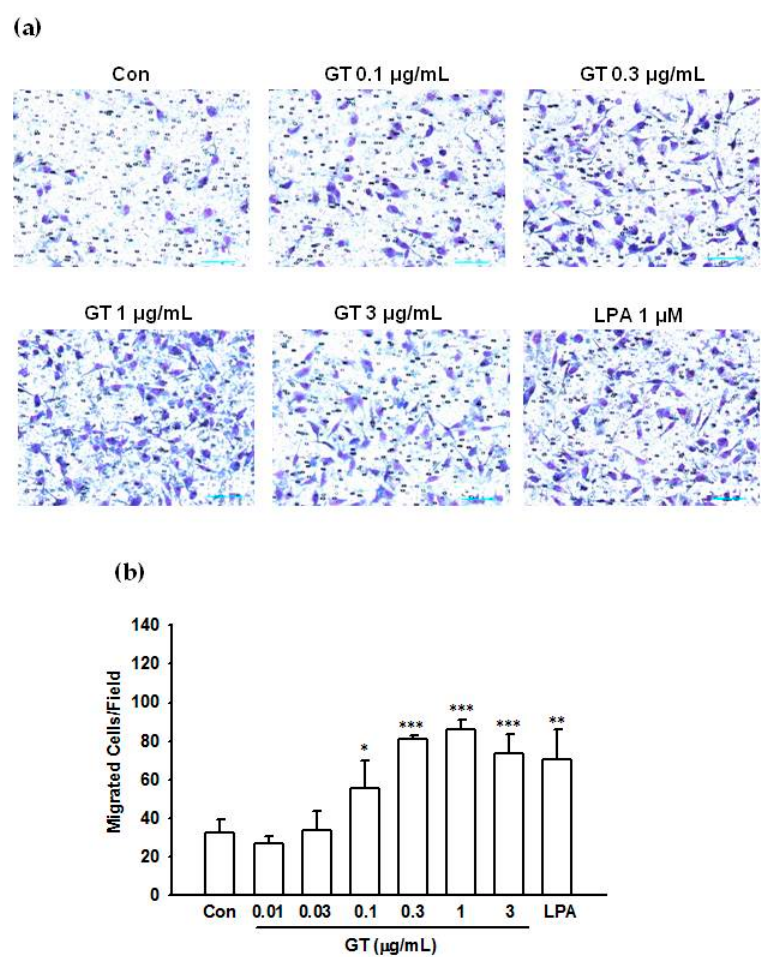
Figure 7. Effects of gintonin on PC-3 cell migration. Chemotactic migration was quantitated using modified Boyden chambers, as described in Materials and Methods. Cell migration of PC-3 cells treated with gintonin (0.01–3 μ g/mL) was examined. Data were obtained from 4 fields per well, 4 different wells. ( a ) representative pictures of PC-3 cell migration. ( b ) histograms of the effects of gintonin on migration. Data represent means ± SD. * p < 0.05, ** p < 0.01, *** p < 0.001 compared to control (Con). Con, control; GT, gintonin.